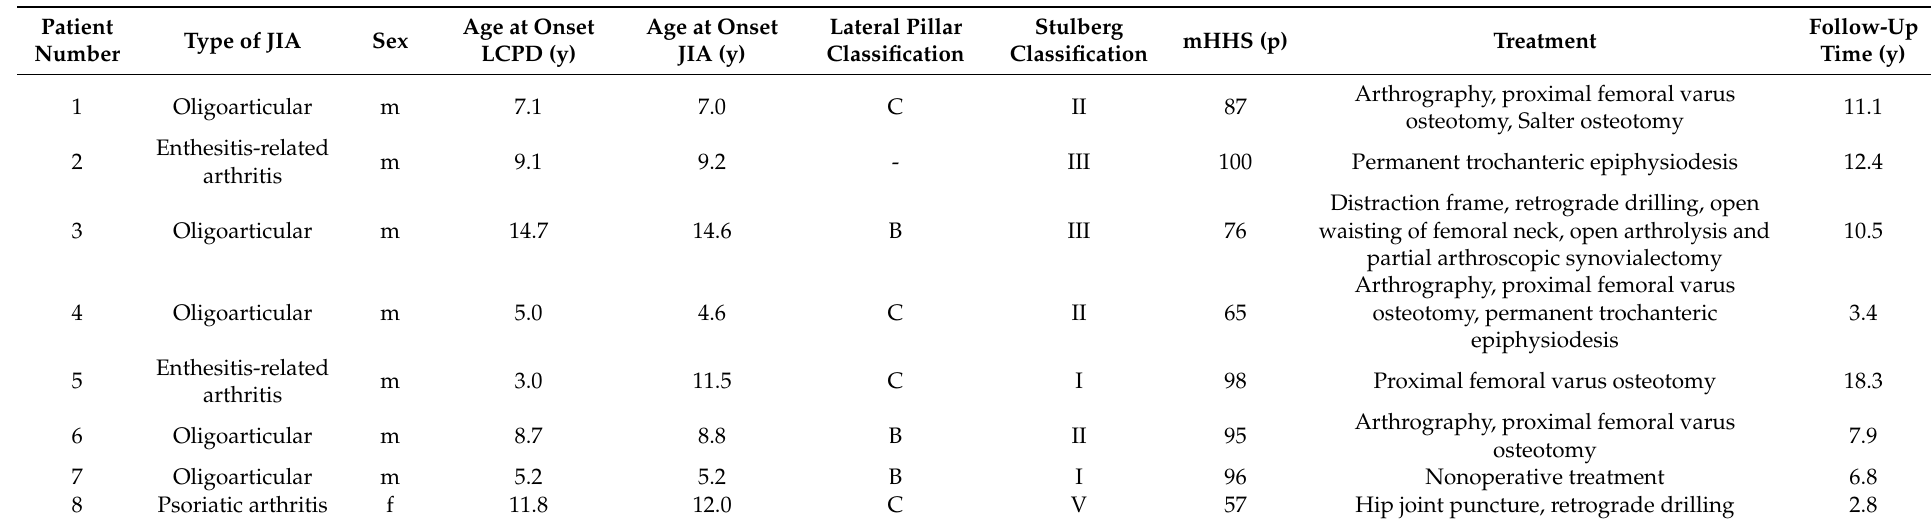
Table 1. LCPD patients with a verified diagnosis of juvenile idiopathic